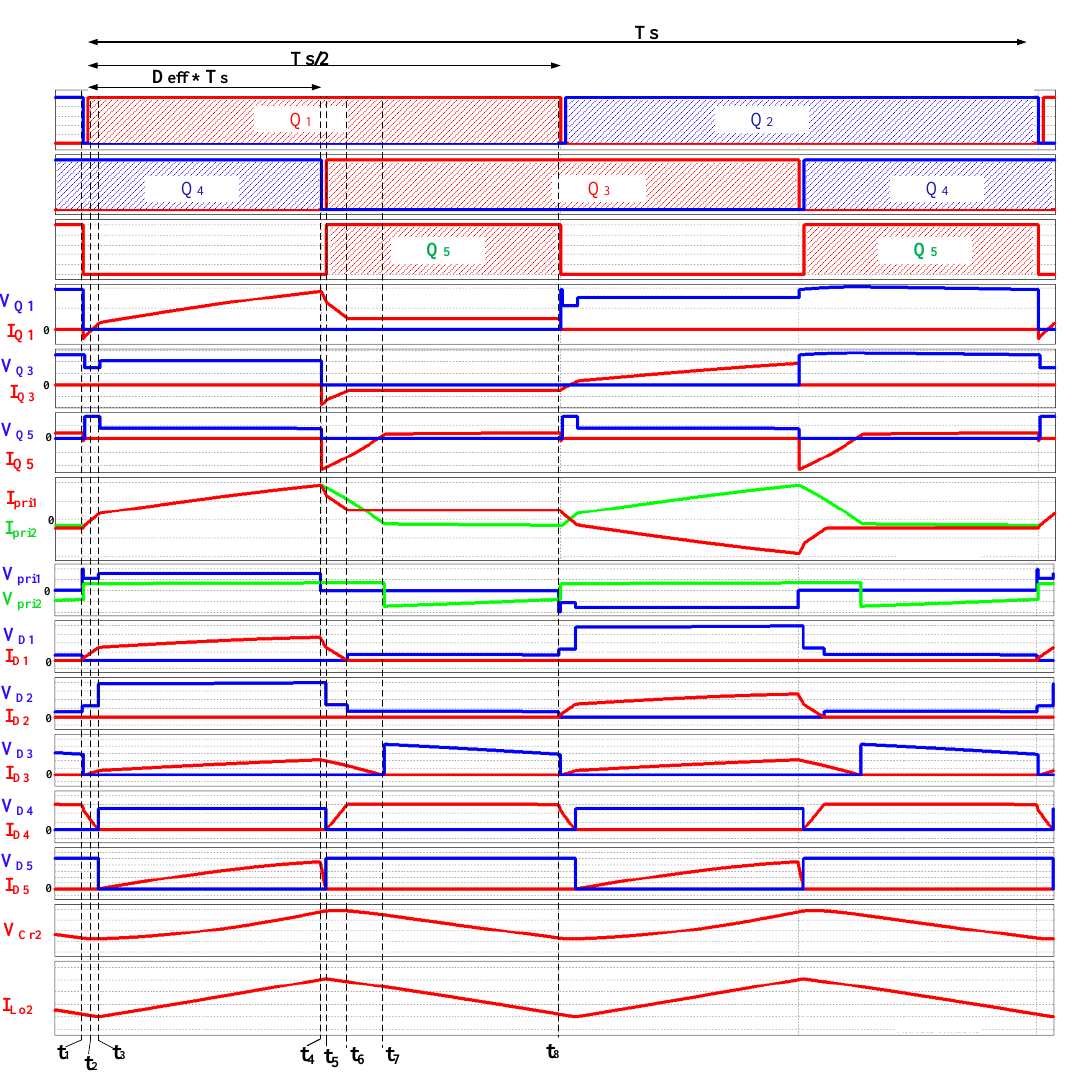
Figure 2. LDC converter of the proposed integrated OBC.